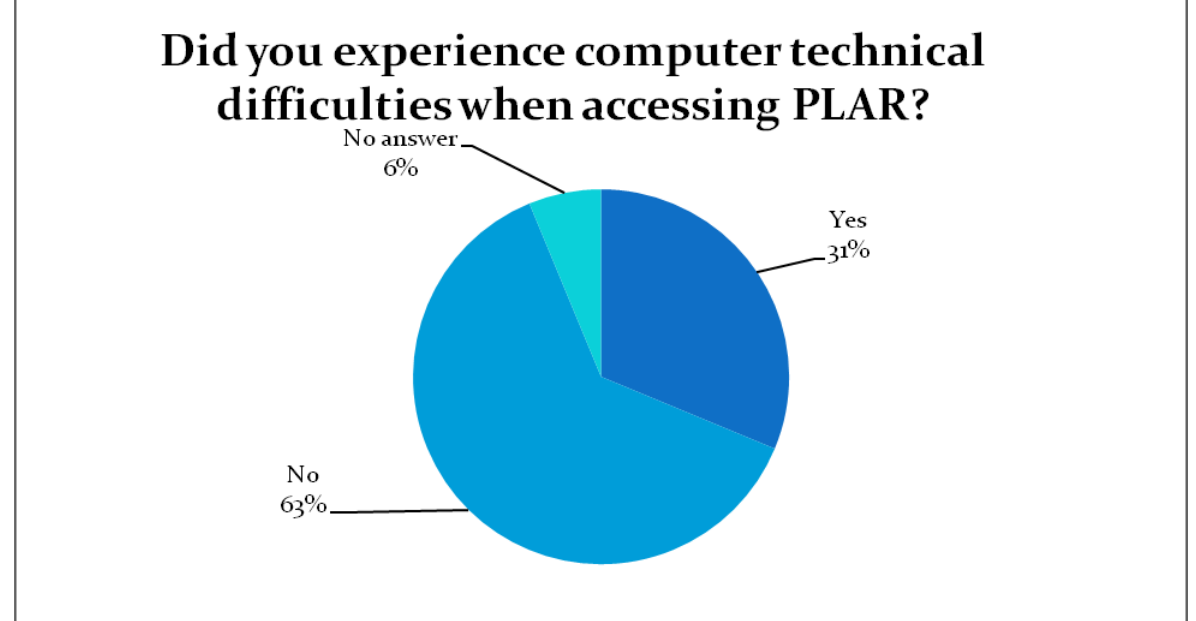
Figure 5 . Helpfulness of PLAR user